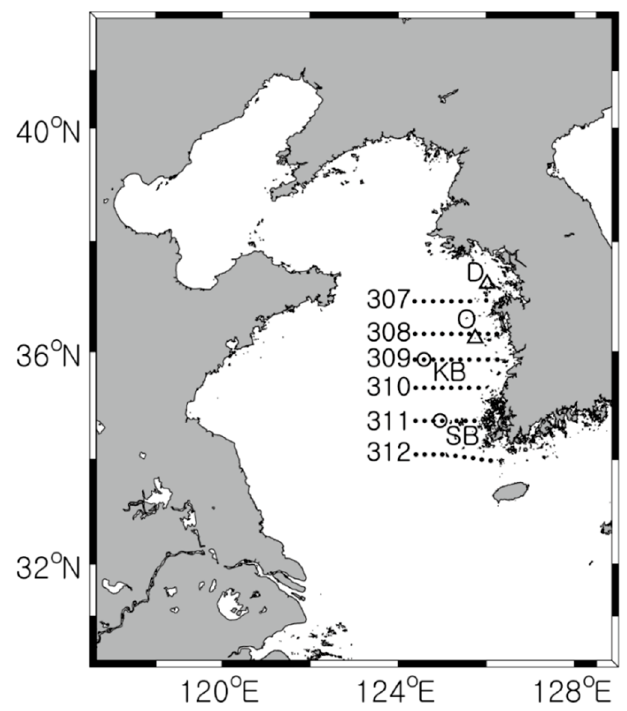
Figure 1. Ocean buoy stations (triangles for D and O; open circles for KB and SB) and the bi-monthly routine hydrographic observation stations (dots) of the National Institute of Fisheries Sciences, Korea. The number indicates bi-monthly routine oceanographic observation lines.